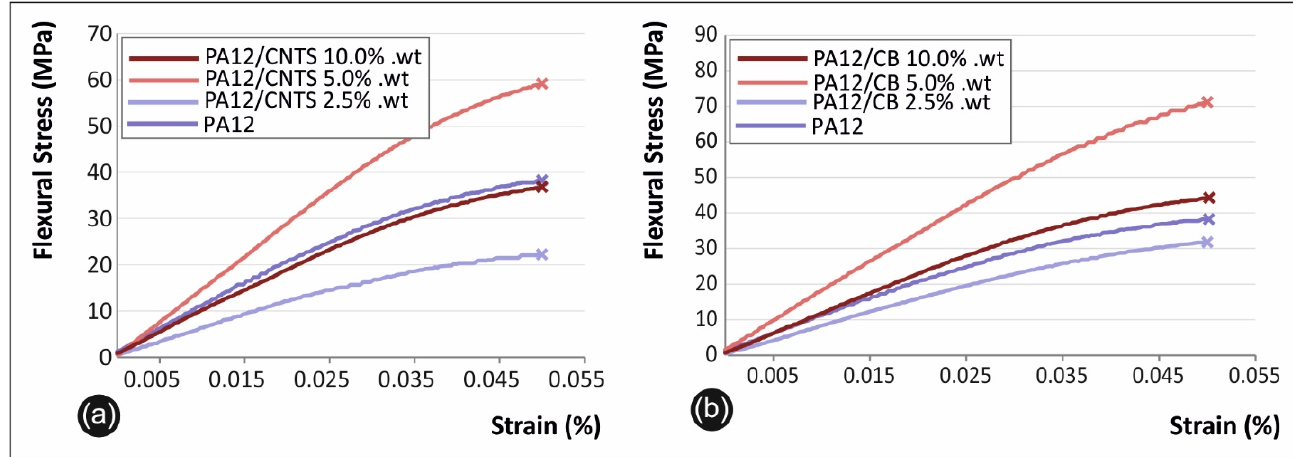
Figure 12. Flexural (representative and comparative) stress–strain curves for ( a ) PA12 and PA12/CNT, as well as ( b ) PA12 and PA12/CB nanocomposites.